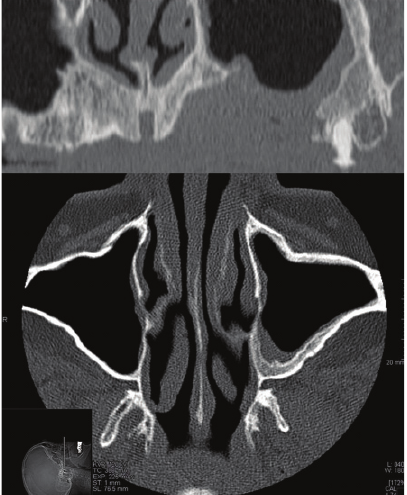
(G4 + G5) highlighted a statistically significant results in terms of clinical improvement ( P = 0 . 0061) (Table